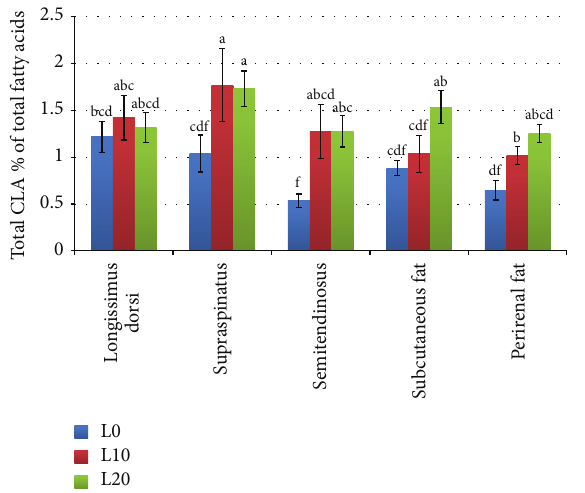
Figure 4: n-6: n-3 ratio in muscles and fat tissues of goats fed diets containing different levels of whole linseed. Error bar = (1SE). Bars with different alphabet notation differ